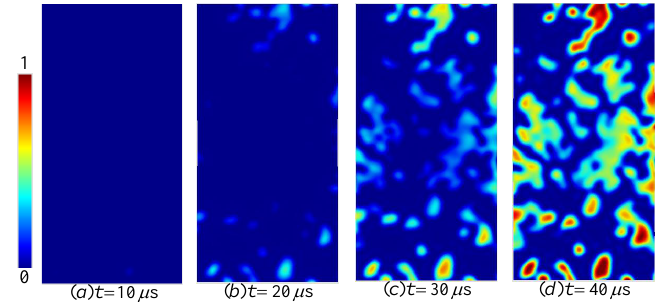
Figure 13. The evolution of damage field for the low amplitude load and cohesion realization with l c = 10 mm at times: ( a ) 16 µ s, ( b ) 26 µ s, ( c ) 36 µ s, and ( d ) 46 µ s.